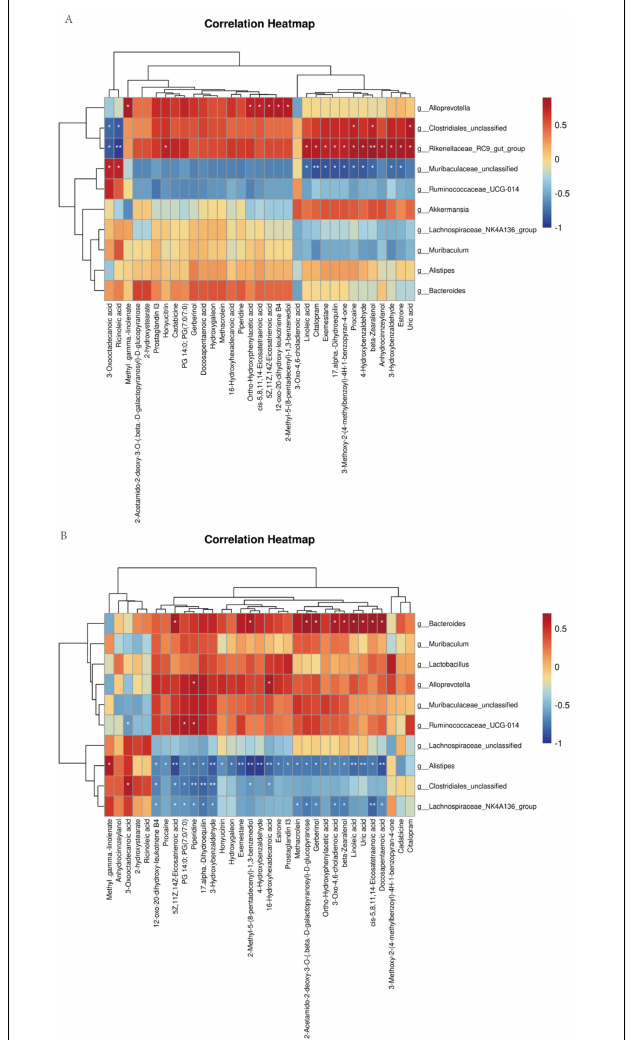
FIGURE 7 | Spearman rank correlation between metabolites and bacterial genera and species. Spearman correlation between statistically different metabolites and bacterial genera was calculated both for Balb/c (A) and C57BL/6J (B)